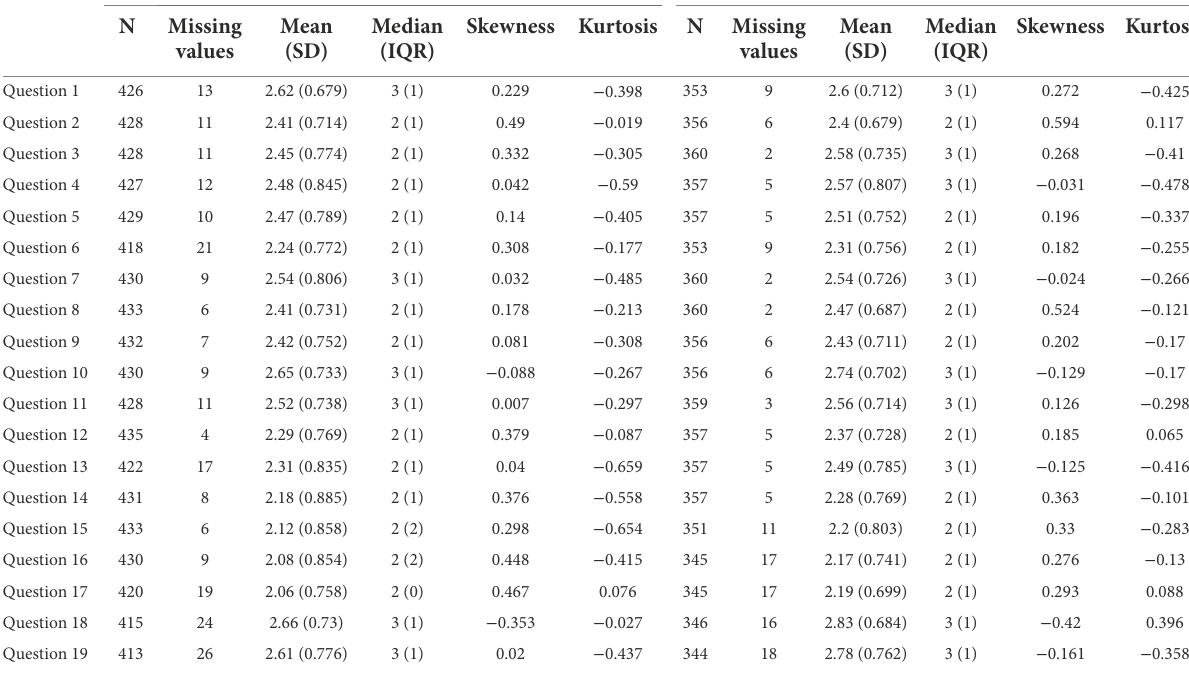
TABLE 2 Descriptive statistics of responses by scale